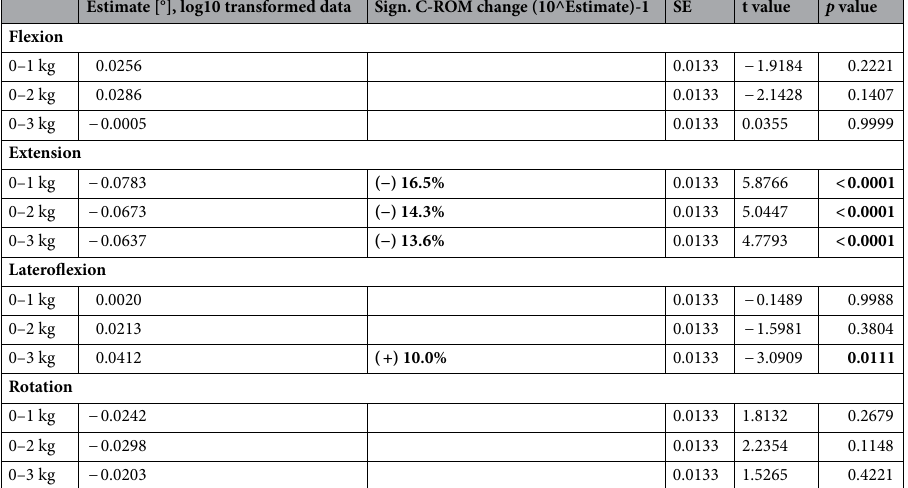
Table 2. Post-Hoc Analysis Table for C-ROM. C-ROM cervical range of motion, Estimate effect size, SE standard error, NA not applicable, kg kilogram, + = increase,—= decrease, % percent. This table shows the post-hoc analysiy of the C-ROM model with the log10-transformed estimates in degrees[°] (fixed effects), significant C-ROM changes in percent with C-ROM-changes in percent [%], standard error and significance